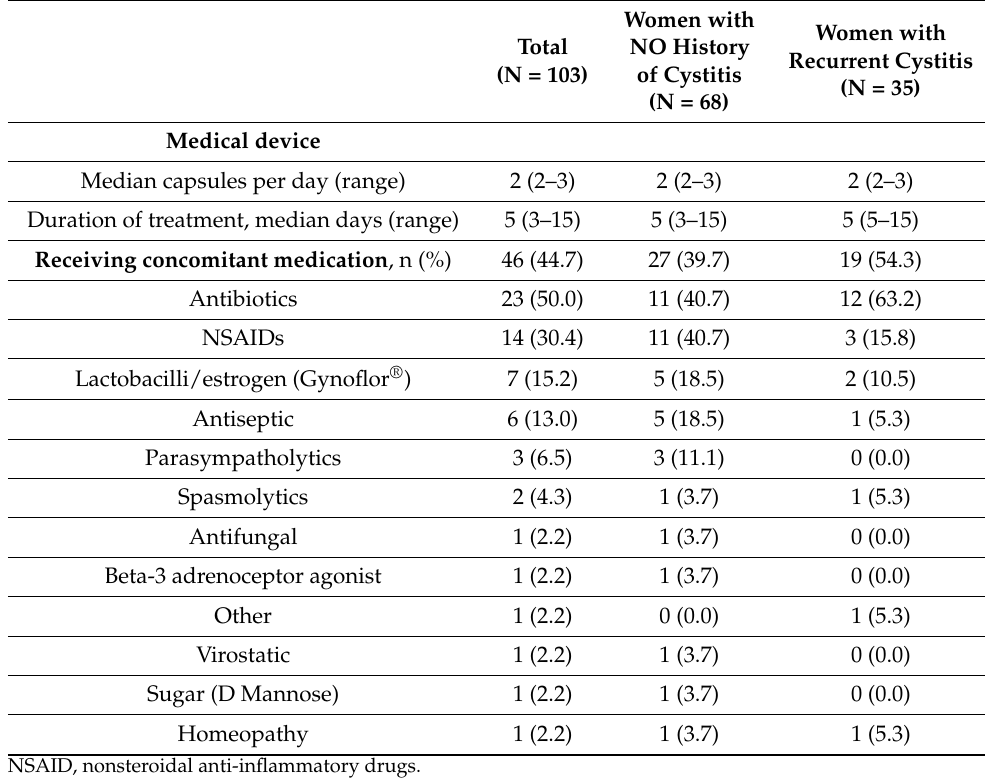
Women with Total